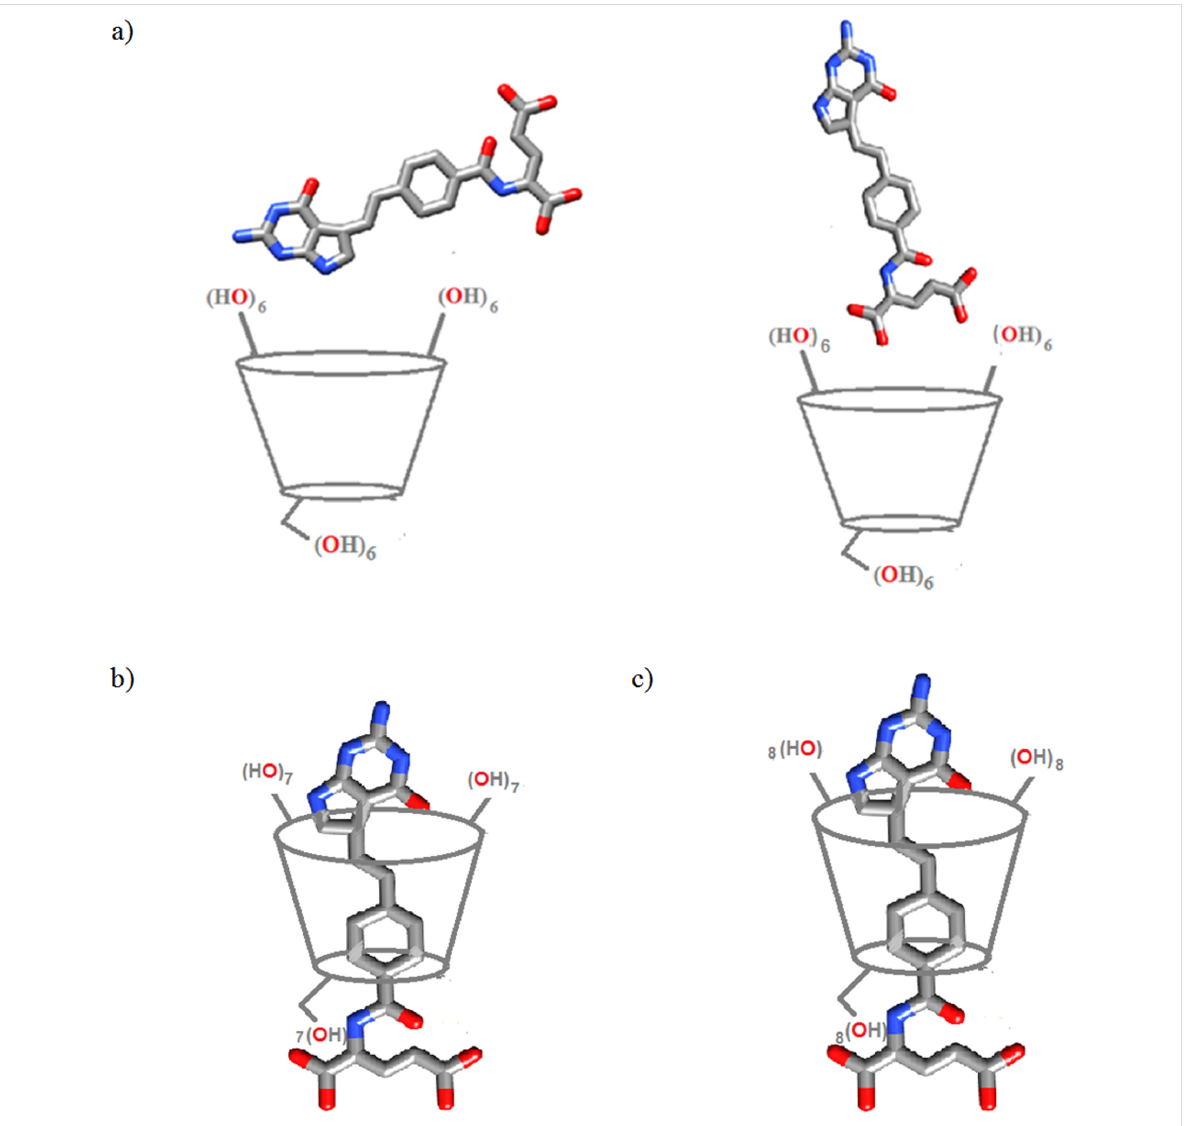
Figure 3: The proposed molecular structures of PTX complexes with α -CD (a: exclusion-type), β -CD (b: rotaxane-like), and γ -CD (c: rotaxane-like); for α -CD/PTX two equally probable conformations are shown.